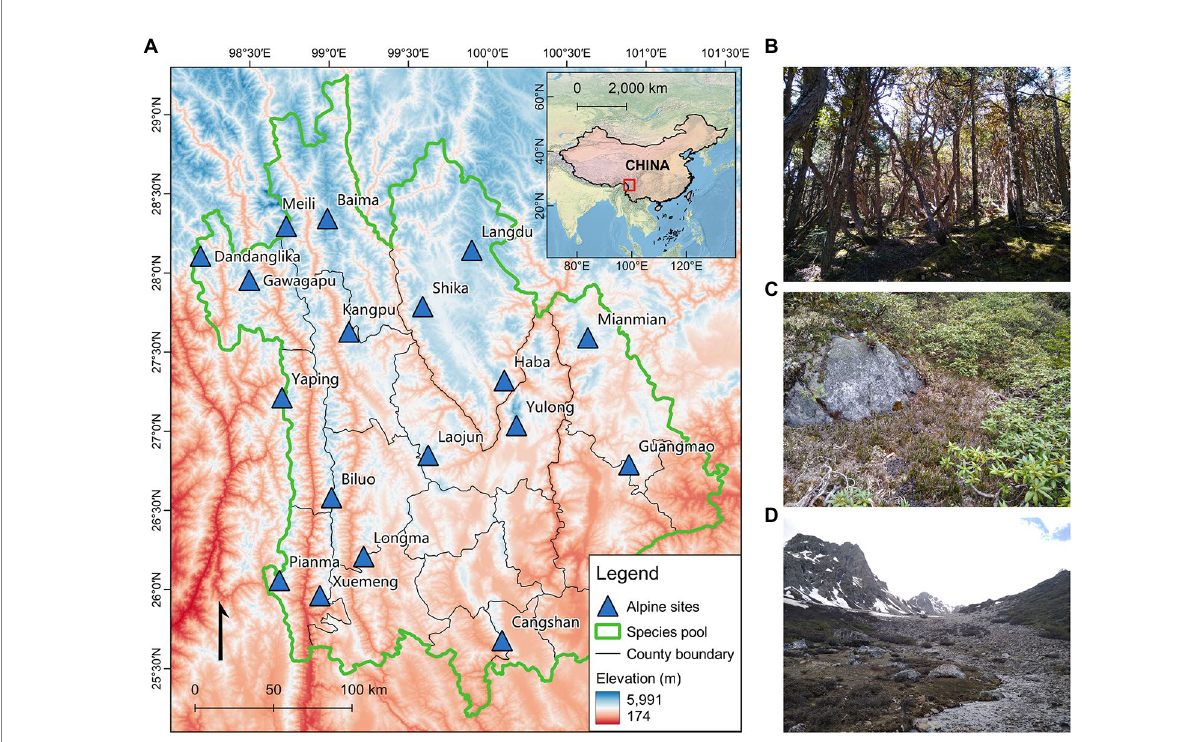
FIGURE 1 Map of the study area and photos showing typical habitat transitions. (A) Topographic map of the extent to which the regional species pool was compiled, including the 18 alpine sites surveyed. The inset map marks the boundary and extent of China, with the study region framed in a red box. The photos to the right show the typical habitat transition in the study sites from below to above the alpine tree line; (B) Dark coniferous forests at 4,000 m a.s.l., (C) dwarf shrubs at 4,200 m a.s.l., and (D) meadows and scree at 4,400 m a.s.l. (Photo taken at Baima Mountain in June